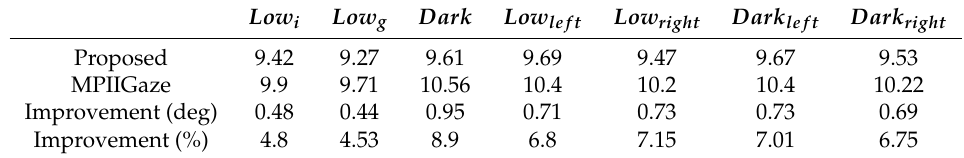
Table 2. Comparison of the performance between the MPIIGaze protocol and the proposed approach. Low i Low g Dark Low left Low right Dark left Dark right Proposed 9.42 9.27 9.61 9.69 9.47 9.67 9.53 MPIIGaze 9.9 10.56 10.22 Improvement (deg)